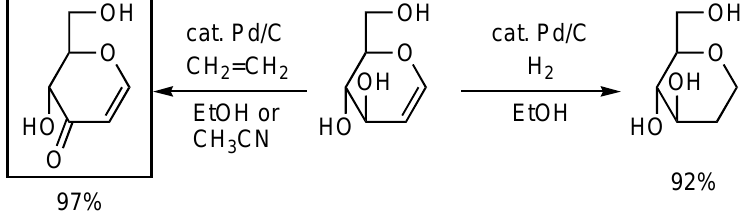
Scheme 1. Hydrogen transfer reaction using Pd/C–ethylene